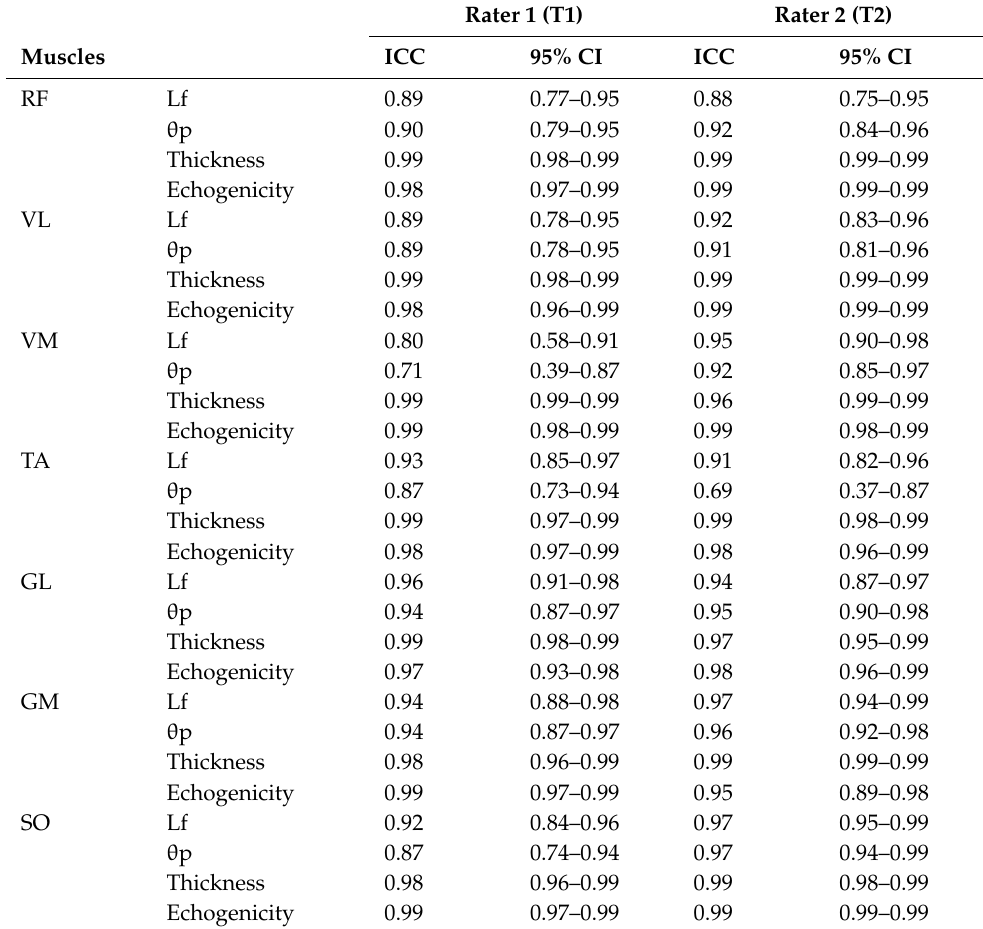
Table 2. Intra-rater reliability and 95% CI of the muscle and tendon architecture and echogenicity from the sample ( n = 20) of Raters 1 and